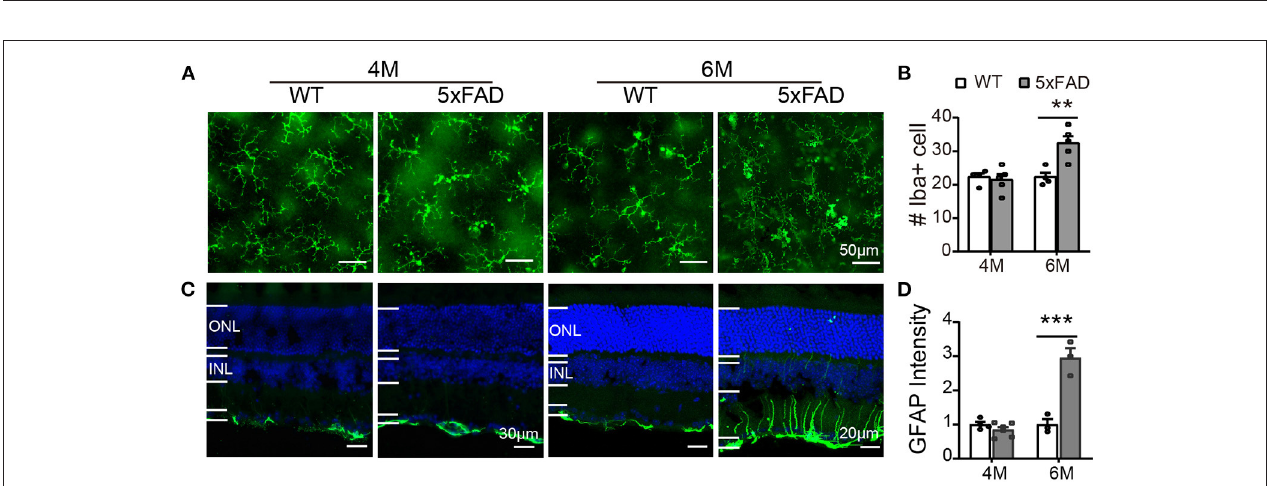
FIGURE 9 | Reactive gliosis happens in 5xFAD at 6 months. (A) Images of Iba1 staining (green) on whole mount retinas of WT and 5xFAD mice at 4 and 6 months. (B) Number of Iba1 + cells on retina (an image size of 320 × 320 µ m). (C) Images of GFAP staining (green) on retinal sections of WT and 5xFAD mice at both ages. Note the difference in scale. (D) The GFAP intensity in the inner retina, normalized to the WT control. ONL, outer nuclear layer; INL, inner nuclear layer; GCL, ganglion cell layer. Data shown as mean ± SEM. ** p < 0.01; *** p < 0.001, two-way ANOVA.